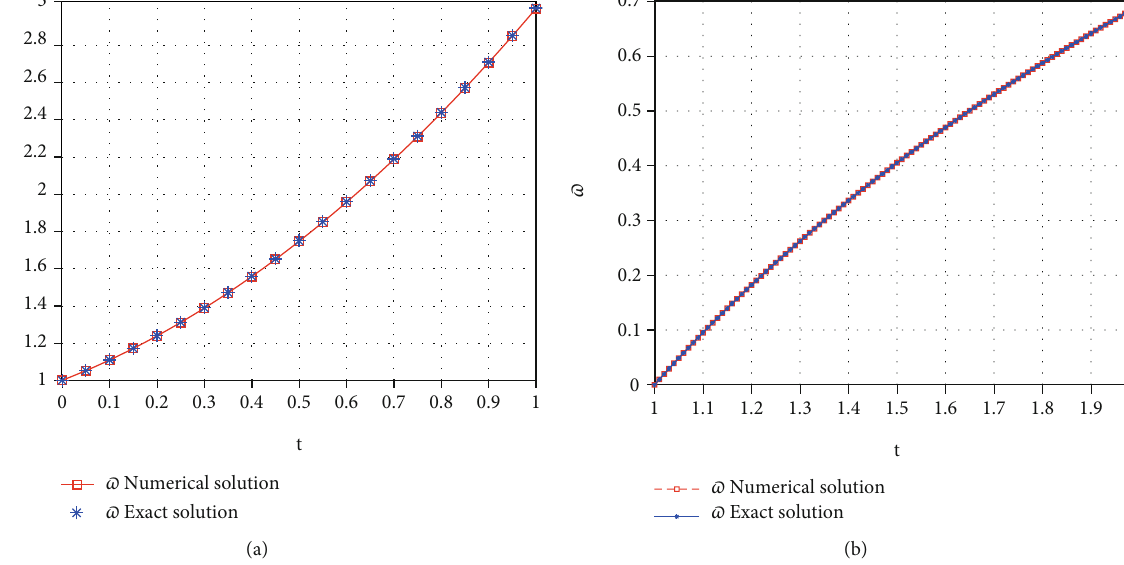
Figure 2: Exact and approximate solutions with h = 0 : 01 : (a) Example 5 when γ = 2 and ℘ = 1/2 : (b) Example 6 when γ = 2 and ℘ = 1